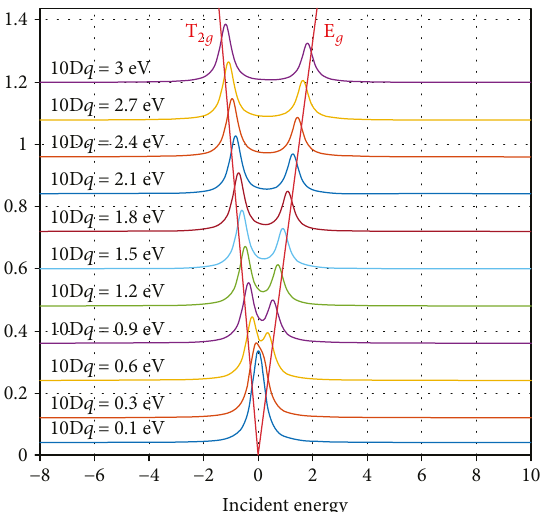
Figure 13: Calculated 1s XAS projections of a 1s2p RIXS for Ti 4+ (3d 0 ) scaling the octahedral crystal fi eld parameter 10D q from 0.1eV to 3.0eV with an energy level diagram as overlay. The splitting of the 3d level into the two peaks T crystal fi eld is